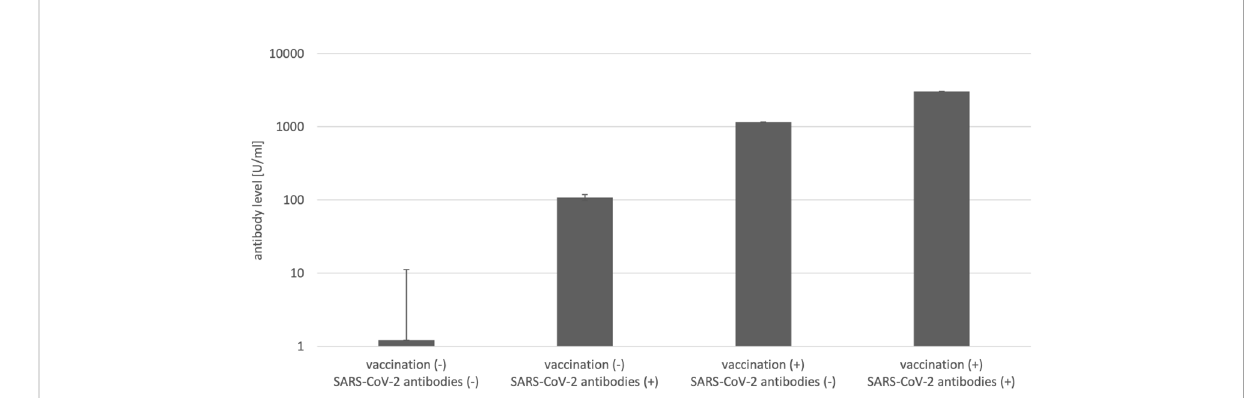
FIGURE 1 Antibody levels in June according to vaccination status and antibody test result in January 2021